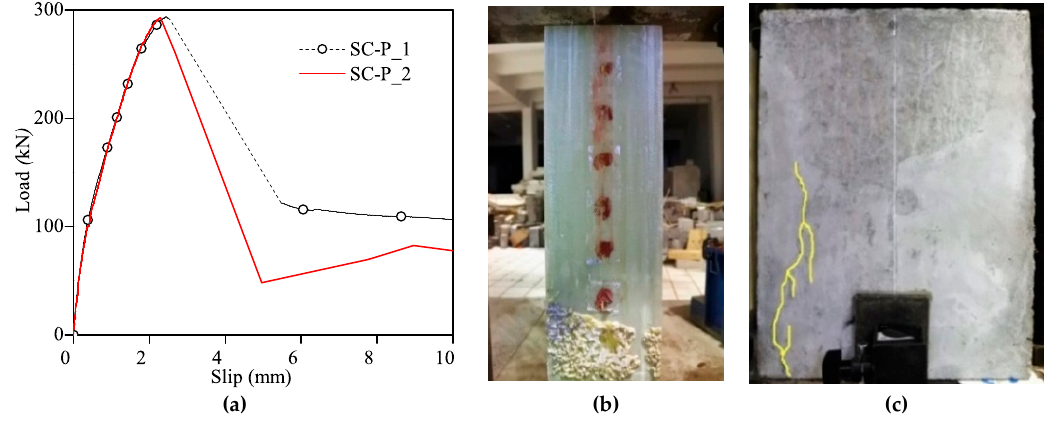
Figure 5. Specimen SC-P test’s result. ( a ): load-slip curves. ( b ): GFRP plate’s failure pattern. ( c ): loaded end crack.